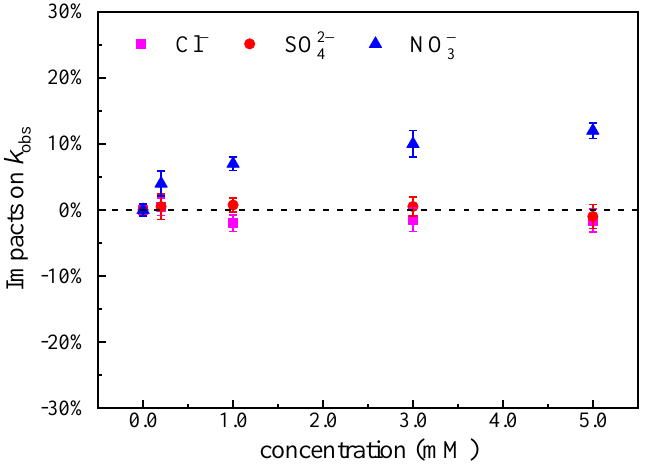
Figure 8. Impacts of inorganic anions on the pseudo first-order constants of MTZ ( k obs ). ([MTZ] 0 = 10 μM, [ H 2 O 2 ] 0 = 100 μM, and I 0 = 7.50 × 10 − 6 Einstein L − 1 s − 1 , l = 0.935 cm).